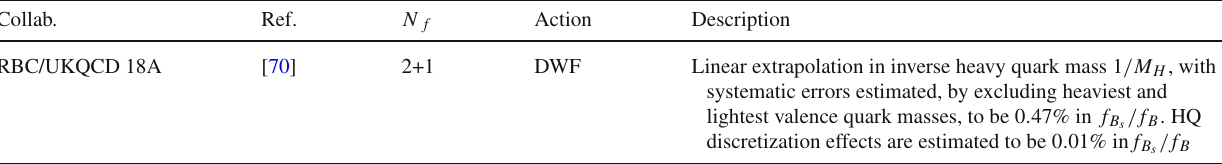
Table 147 Heavy-quark treatment in N f = 2 + 1 determinations of the B -and B s -meson decay constants Collab.